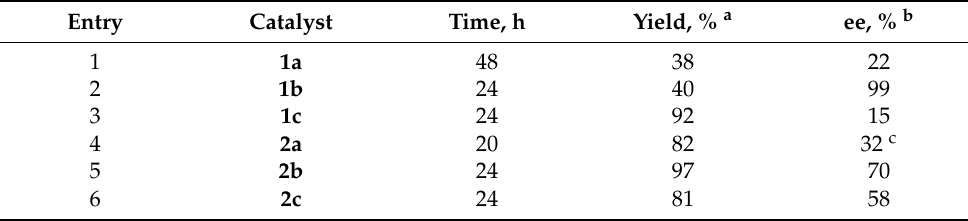
Table 4. Effect of the monoaza macrocycles ( 1 or 2 ) in the MIRC reaction of benzylidenemalononitrile ( 17 ) with diethyl bromomalonate ( 18 ).